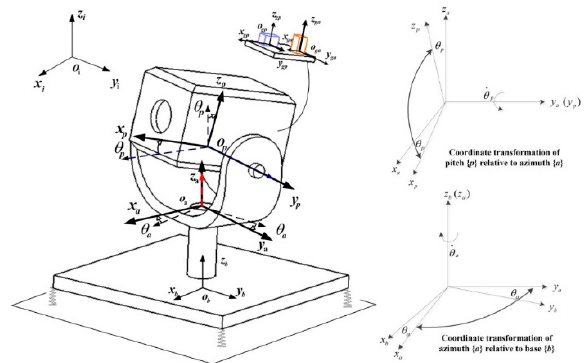
Figure 5. The coordinate and motion definitions of the system.